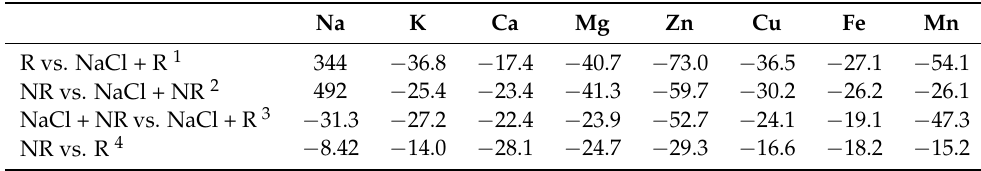
Table 4. Comparison of the mean content of Na, K, Ca, Mg, Zn, Cu, Fe, and Mn in products cooked with or without salt, and rinsed or not rinsed,